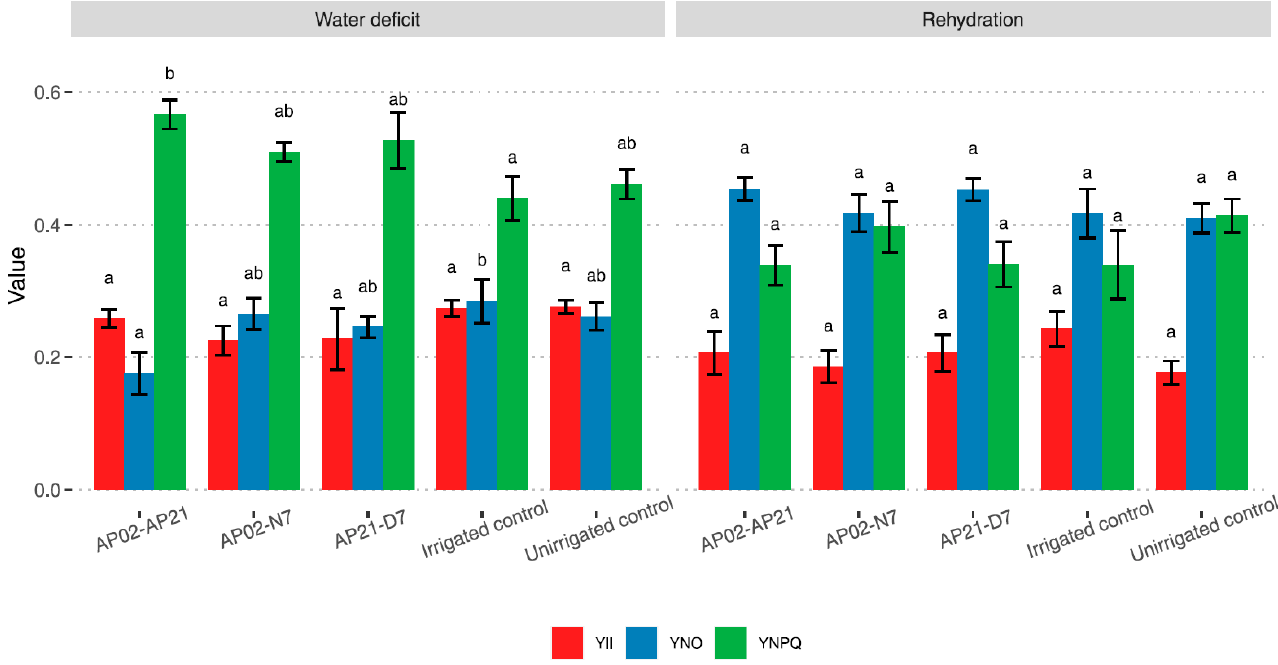
Figure 1. Calculated distribution of the absorbed light in the leaves of perennial ryegrass after 10 days without irrigation and 3 days after rehydration. YII: energy used in photochemistry, YNPQ: energy lost by ∆ pH- and zeaxanthin-dependent mechanisms, YNO: energy loss through non- regulated mechanisms. AP02–AP21: Herbaspirillum sp. AP02 and Herbaspirillum sp. AP21; AP02–N7: Herbaspirillum sp. AP02 and Pseudomonas fluorescens N7; AP21–D7: Herbaspirillum sp. AP21 and Azospirillum brasilense D7. Each value represents the mean of the replicates from the two independent experiments ± SE. Different letters indicate statistically significant differences observed according to the Fisher’s LSD test with Bonferroni correction ( p < 0.05). Stomatal conductance of plants under water deficit was almost seven times lower than the irrigated control plants, but it was not affected by the inoculation of bacteria (Figure 2A). After rehydration, plants from two PGPB treatments (AP02–AP21 and AP21– D7) showed higher stomatal conductance than the unirrigated control. The loss of water (RWC) in the leaves showed a similar trend—leaves lost between 48.01% and 49.06% in all treatments without irrigation on day 10. Nevertheless, the plants inoculated with PGPB showed a significantly higher RWC compared with the non-inoculated plants after rehydration ( p < 0.05) (Figure 2B).